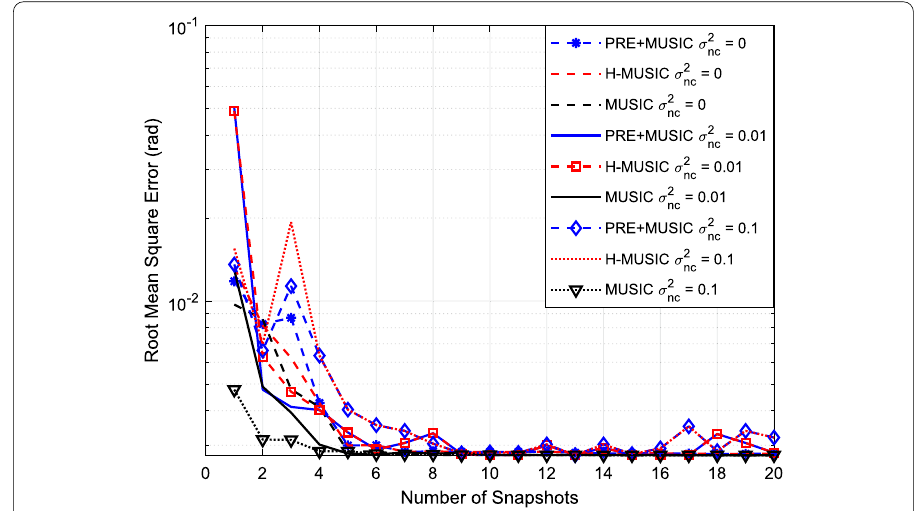
Fig. 7 RMSE of AoA estimation for the partially connected architecture, M c = 500 , SNR = 20dB , S 1 = 1 : 20 , S 2 = 4 : 80 snapshots ( S 2 = TS 1 where T = 4 ), (cid:31) = 1cm